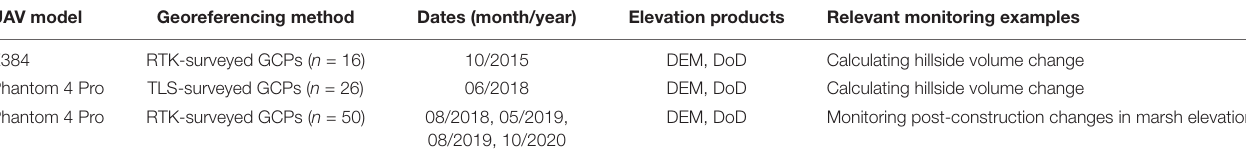
TABLE 2 | Dates and basic methods for UAV-derived elevation products.